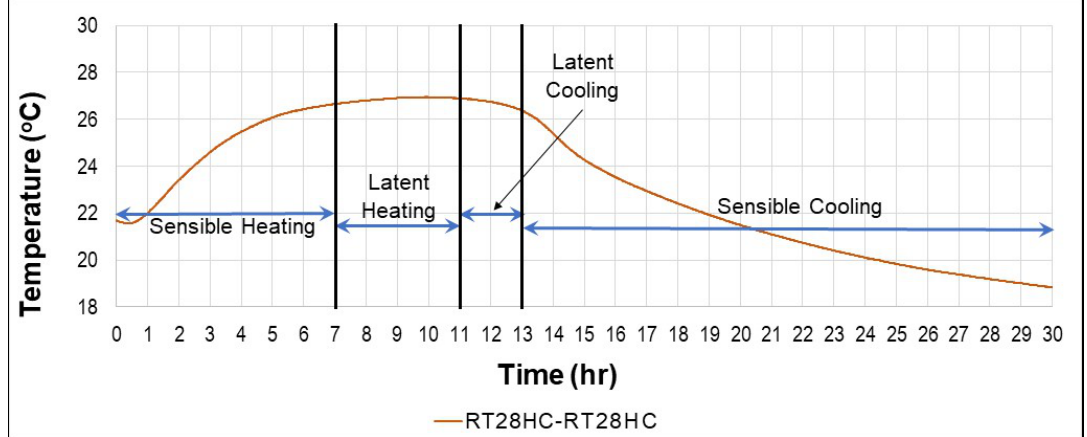
Figure 10. Sensible and latent heating–cooling regions for PCM RT28HC–RT28HC sample in HTH. The trends for interfacial temperatures T2–T3–T4 and T10–T11–T12 give a clear